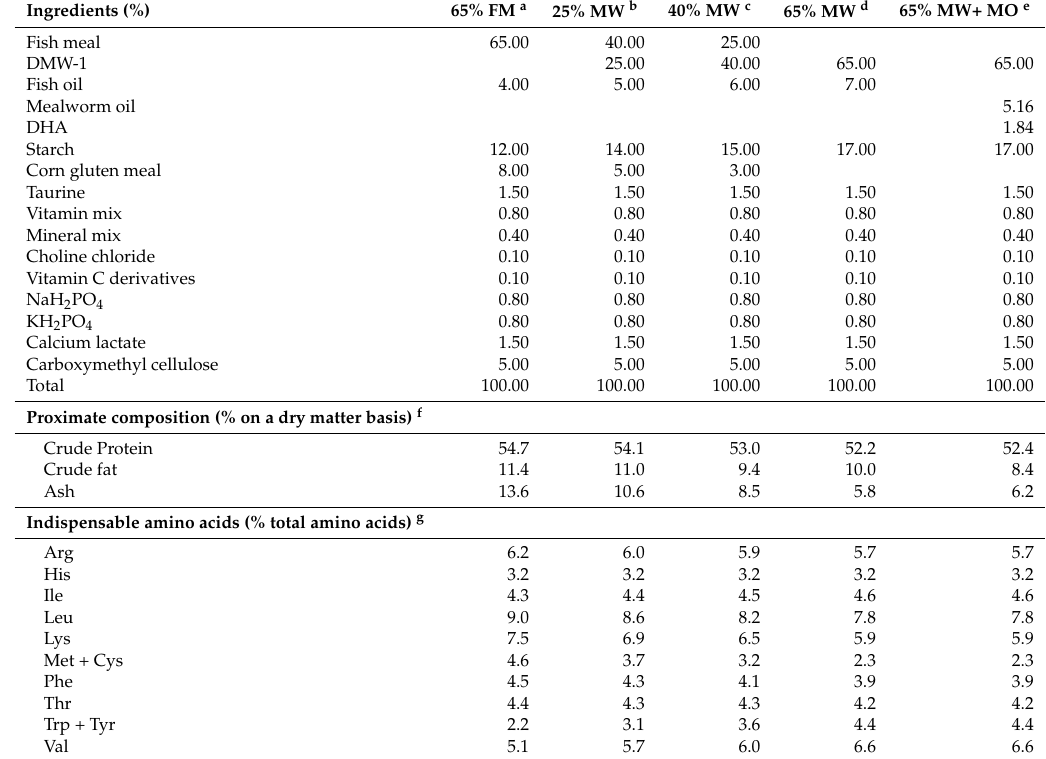
Table 1. Formulation, proximate composition, and amino acid composition of the diets fed to red seabream for the growth test for 4